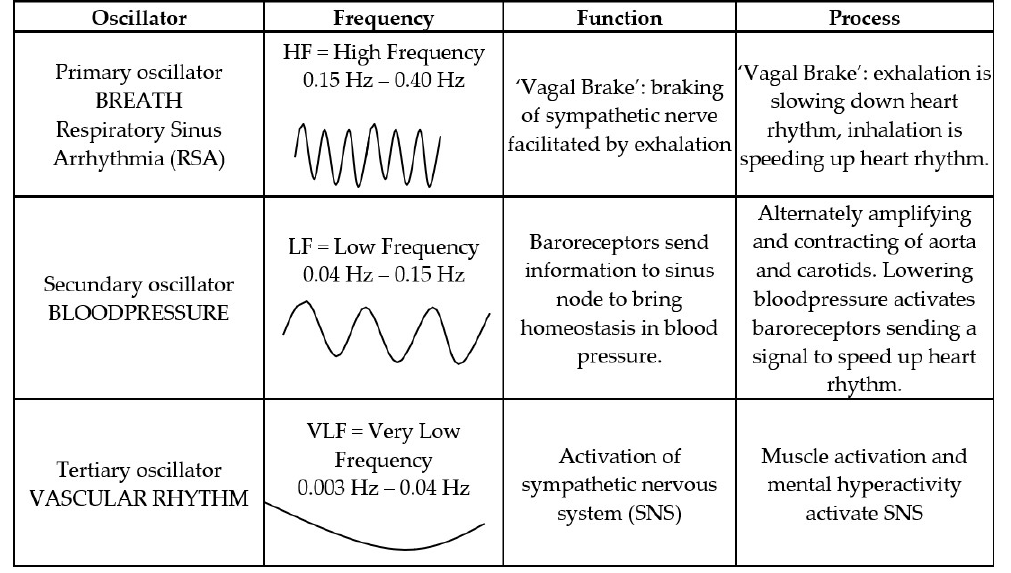
Figure 2. HRV as composition of 3 oscillation processes [7] However, when clients shift to slow effortless breathing patterns (as shown Until 1996, HRV was primarily used as marker of the autonomic nervous system, but in 1996 Paul Lehrer (in collaboration with Evgeny Vaschillo) reported the observation that if you breath in the frequency of the baroreceptor and you slow down the tertiary oscillator (quietly not moving too much) than the ANS come into autonomic balance. The body can be brought into the state of autonomic balance through guided breathing with HRV-Biofeedback. Breathing in the resonance frequency (between 0.05 and 0.15 Hz, which is the same as 4–7 breaths per minute) can be compared to guiding someone on a swing by pushing the swing at the correct moment to optimize their swing (resonance). Breathing at resonance frequency trains the reflexes of the cardiovascular system, in particular the baroreflex [19]. Breathing in the resonance frequency (resonance between respiratory and baroreflex rhythms) and using HRV-Biofeedback creates autonomic balance in the ANS and in this study we will show the effects of training Autonomic Balance with HRVB.